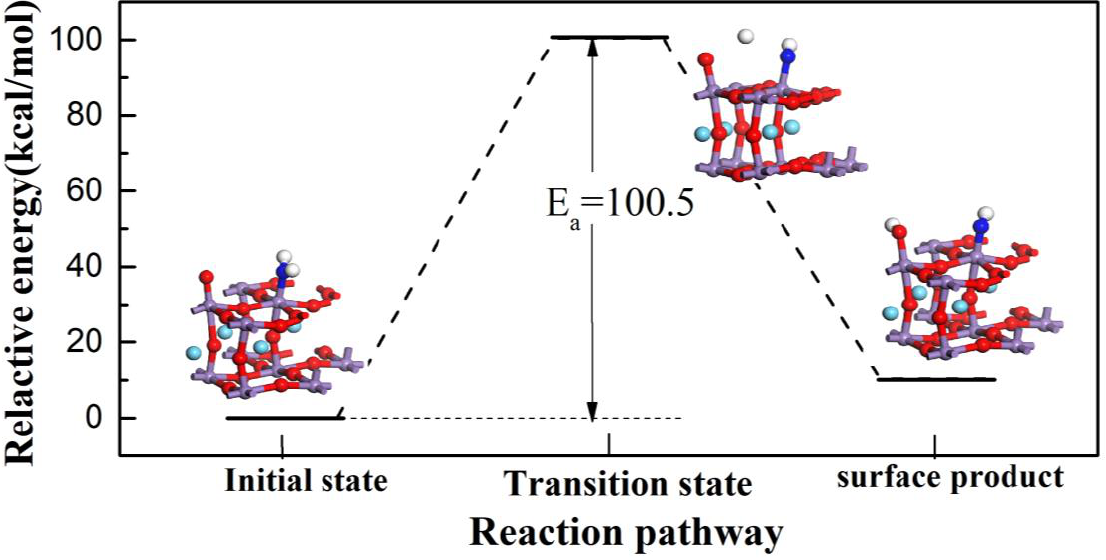
Figure 10. The dehydrogenation process of NH 2 under the action of active O oxygen. Under aerobic conditions, there are NO 2 mechanisms that speed up the SCR process.